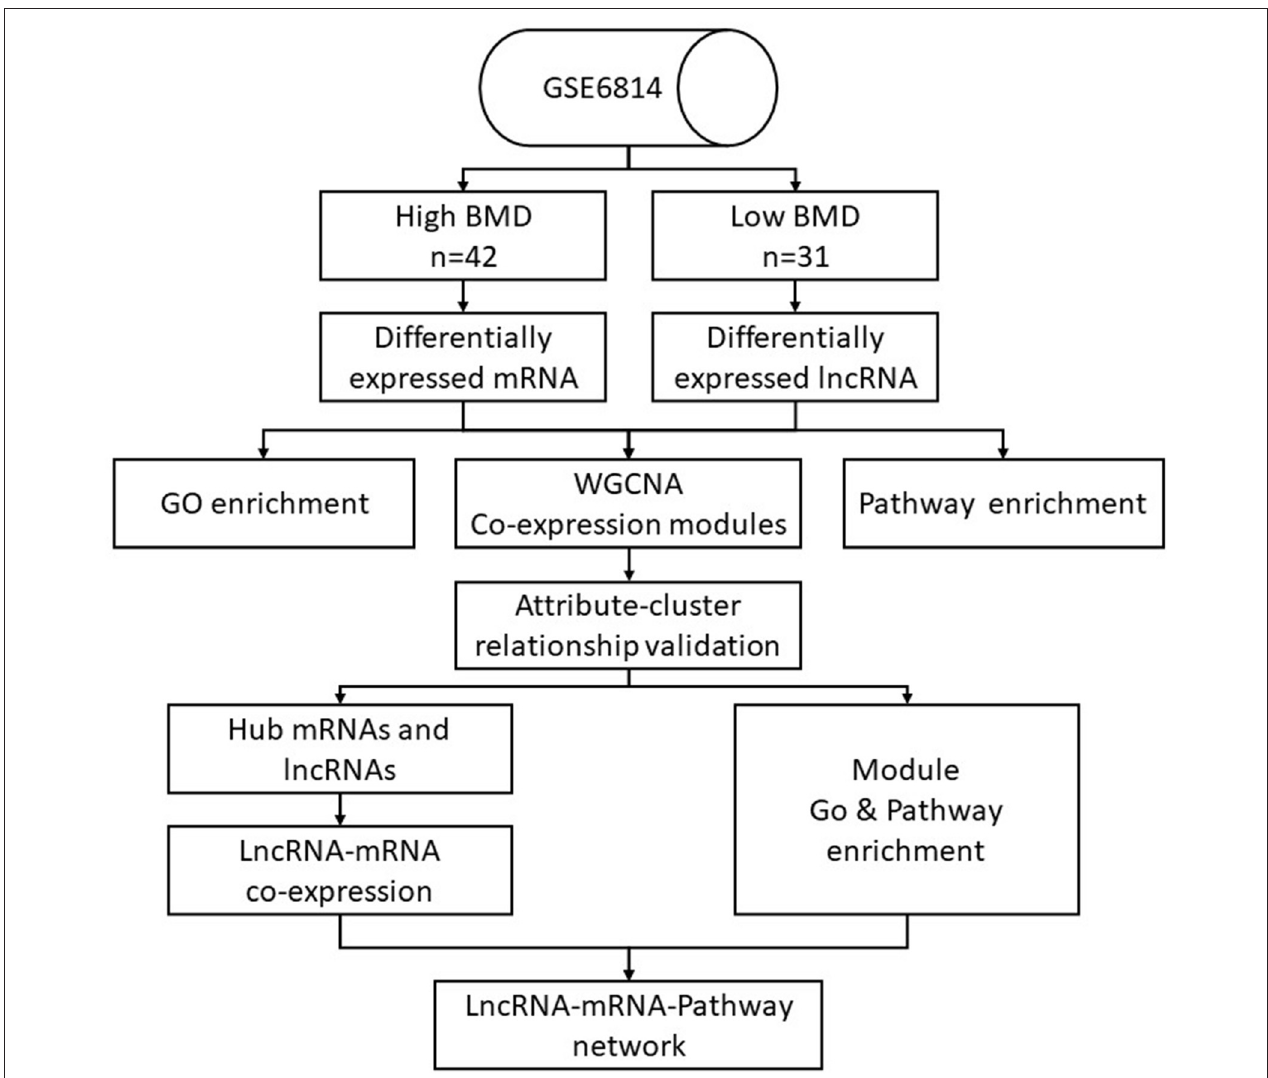
FIGURE 1 | Data management flowchart of the study.